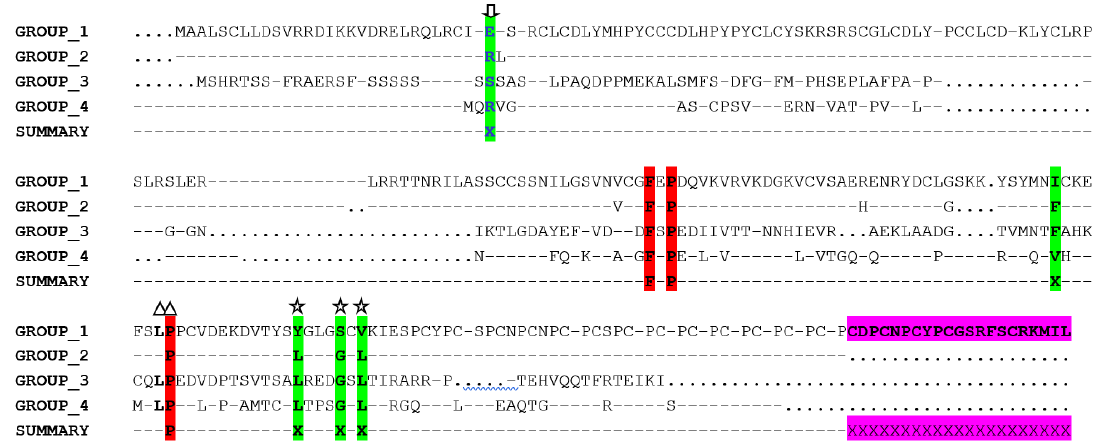
Figure 3. Evolutionary trace analysis of the small heat shock protein (sHSP) gene family in human, mouse and cattle. Every member of sHSPs was partitioned into four different groups based on the degree of conservation. Group 1 consists of human, mouse and cattle ODF1 protein. Group 2 consists of HSPB3, HSPB2, CRYAA, CRYAB, HSPB6, HSPB1 and HSPB8; Group 3 consists of HSPB7 while Group 4 consists of HSPB9. Conserved residues were colored red while class specific residues were colored green. A class specific residue was observed in the N terminal domain conferring group specificity to chaperoning functions (indicated by an arrow). Amino acid residues with triangle and star in the figure above have been identified elsewhere (Laksanalamai & Robb, 2004). The presence of an extra 21 amino acid residues in ODF1 gene which is lacking in other sHSP members is highlighted in magenta coloration. The sign “…..” represents the presence of invariant residue in each group while the sign “----” represents the absence of a residue at that